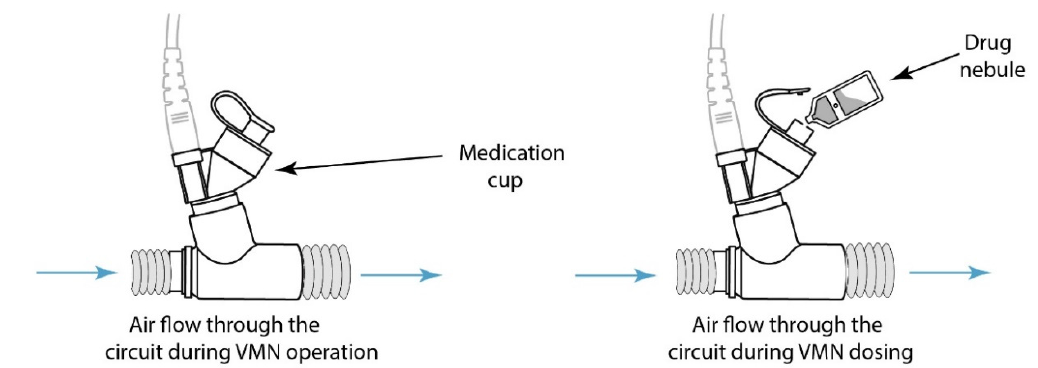
Figure 2. Drug refill for a vibrating mesh nebuliser (VMN) which maintains the closed ventilator circuit and mitigates the risk of release of patient-derived bioaerosol to the local environment.